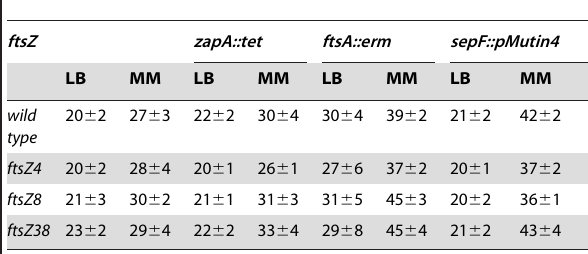
strains grown on Luria Bertani broth (LB) or minimal medium (MM).